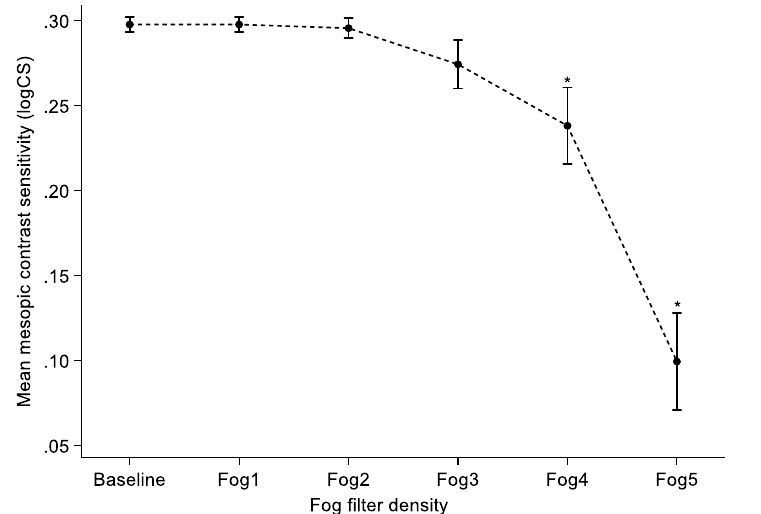
Figure 5. Mean mesopic CS at baseline and under different Fog filter conditions as measured with the Mesotest II. Error bars are 95% confidence interval of means. * = p < 0.001 and represents significant difference in CS at baseline compared with Fog filters 4 and 5.